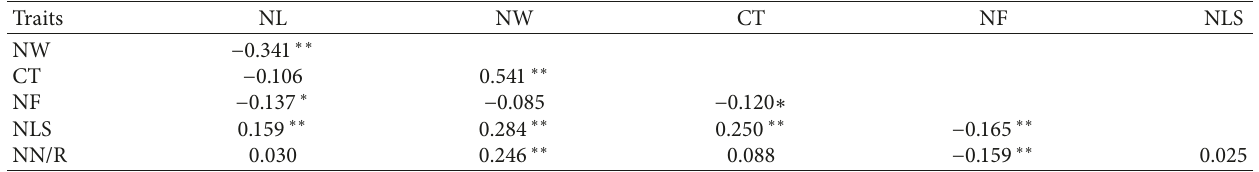
Table 4: Pearson coefficient of correlation between pairs of morphological and anatomical traits studied.